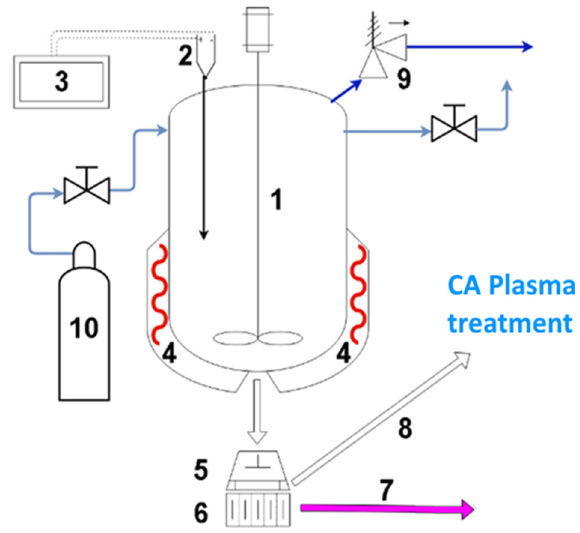
Figure 1. Diagram of the test rig, used for hydrothermal carbonization of the spent grain (1—Autoclave; 2—type K thermocouple; 3—PLC controller; 4—heating mantle, with band heaters; 5—hydraulic press; 6—filter; 7—liquid, after mechanical dewatering; 8—hydrochar from Brewer’s Spent Grain, after mechanical dewatering; 9—pressure relief valve; 10—nitrogen for purging).